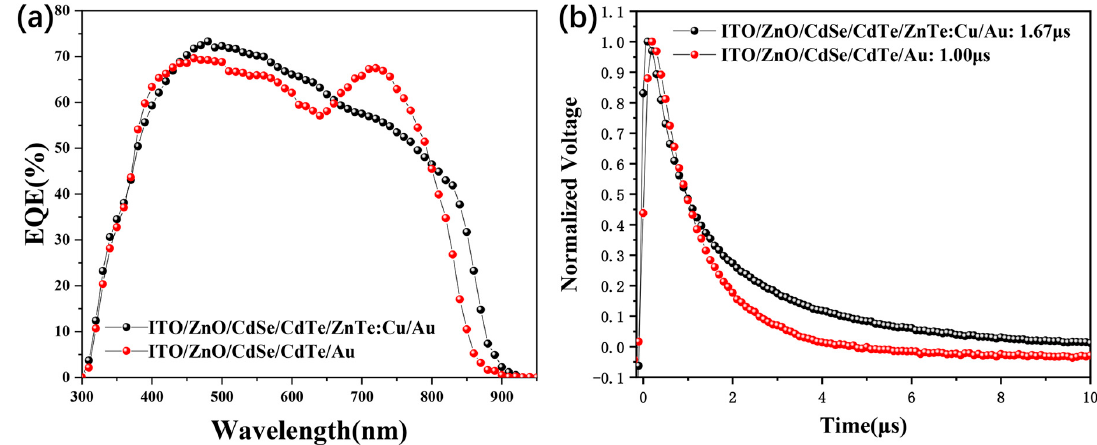
Figure 5. ( a ) External quantum efficiency (EQE) spectrum of a device without a ZnTe:Cu back contact layer; ( b ) transient photovoltage measurements of NC solar cells without a ZnTe:Cu back contact layer.